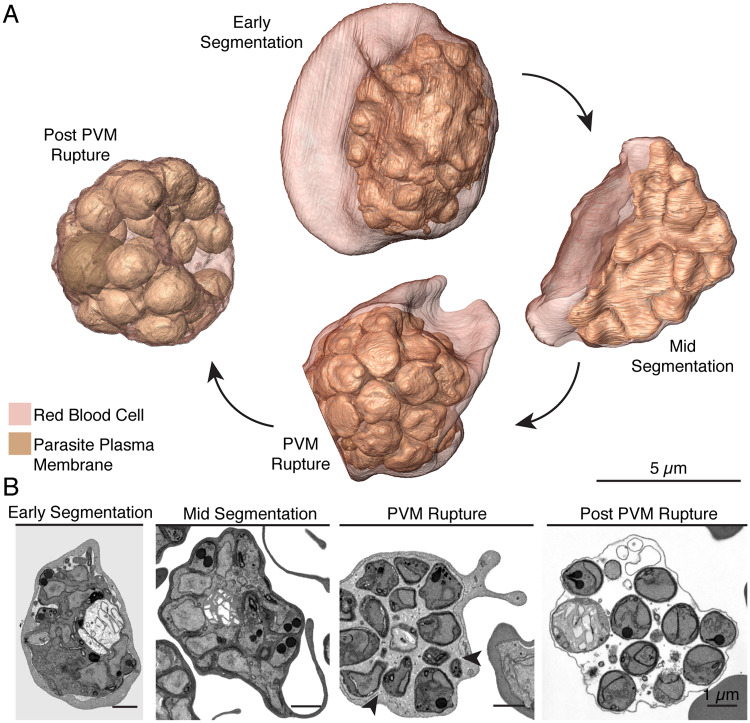
Parasite plasma membrane dynamics throughout segmentation.A. Renderings of the four different schizont stages inside their host red blood cells through segmentation. Scale bars of renderings interpolated from structure sizes in EM data. At early segmentation, the mother parasite plasma membrane begins to invaginate, forming buds for each nascent merozoite that slightly protrude from the mother parasite mass. At mid-segmentation, these buds are more pronounced and jut out of the mother parasite. By PVM-rupture, the parasite plasma membrane cloaks each new merozoite, which is shaped like an inverted cone. Post-PVM rupture, merozoites fill the red blood cell and take on a more spherical shape. B. Single SEM images of the four schizonts chosen for rendering. We note that for the early segmentation schizont, the increased contrast between the parasite plasma membrane and parasitophorous vacuole is an artifact of sample preparation and provides additional contrast helpful for rendering. Arrows indicate region of PVM rupture.